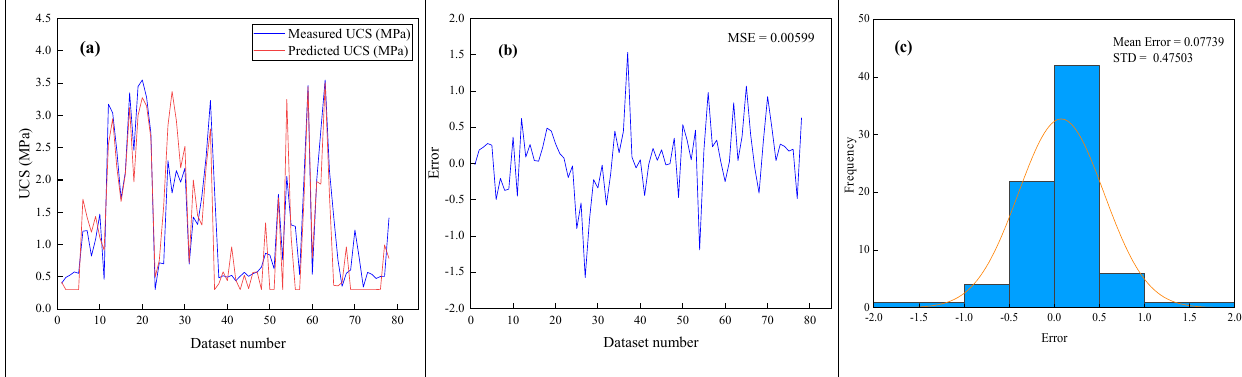
Figure 12e denotes the change in relative error between the measured and predicted